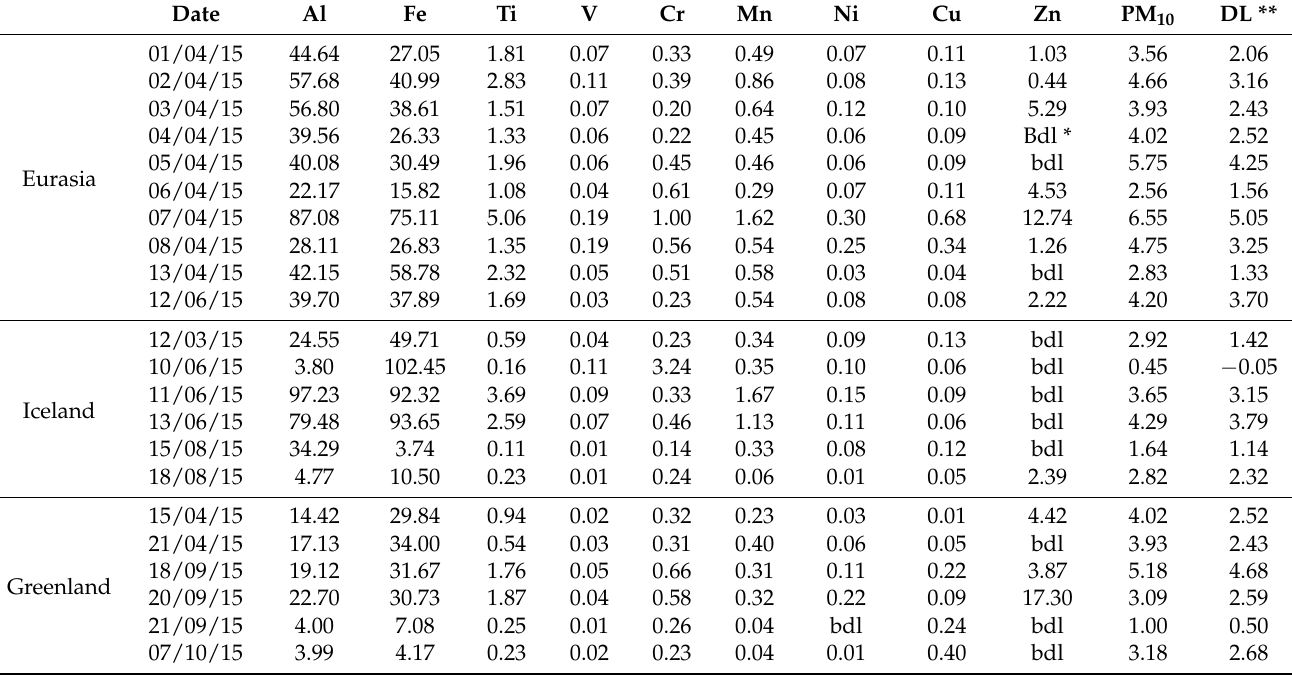
Figure 1. Time series of aerosol mass concentrations at Gruvebadet station, Ny-Ålesund, in 2015. The dotted lines at 0.5 and 1.5 µ g/m 3 provide estimates of background values before and after 10 June 2015. Table 1. Daily metal concentration (ng/m 3 ), PM 10 and dust load (DL, μ g/m 3 ) affecting the potential source contribution function (PSCF) probability plots; average (Avg., ng/m 3 ), relative standard deviation (RSD, %) and number of valid data (VD #) of the overall (196 samples) dataset.